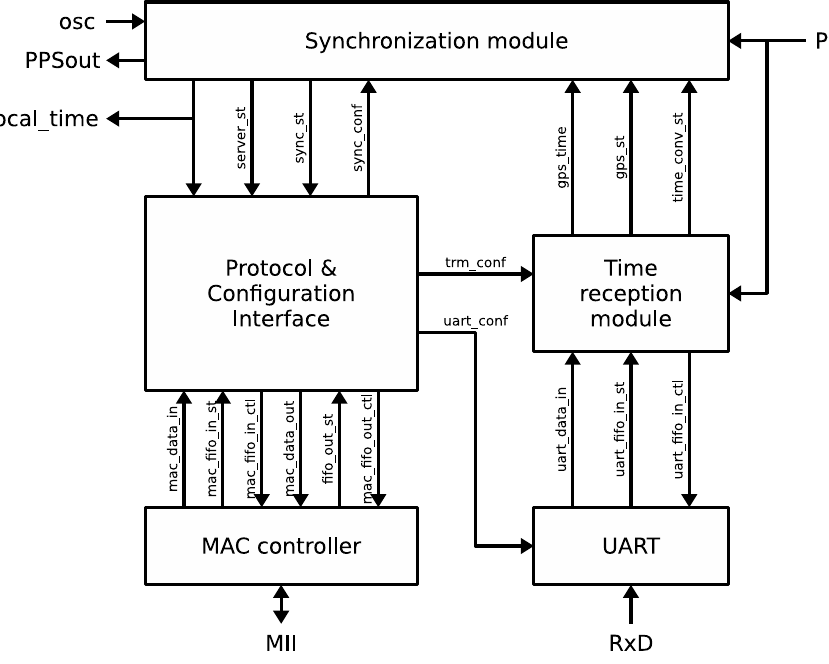
Figure 5. NTP server core block